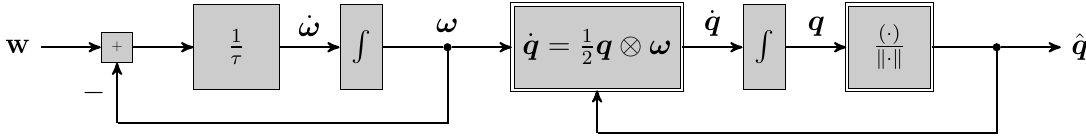
Figure 3. Model of human movement modified according to [19].